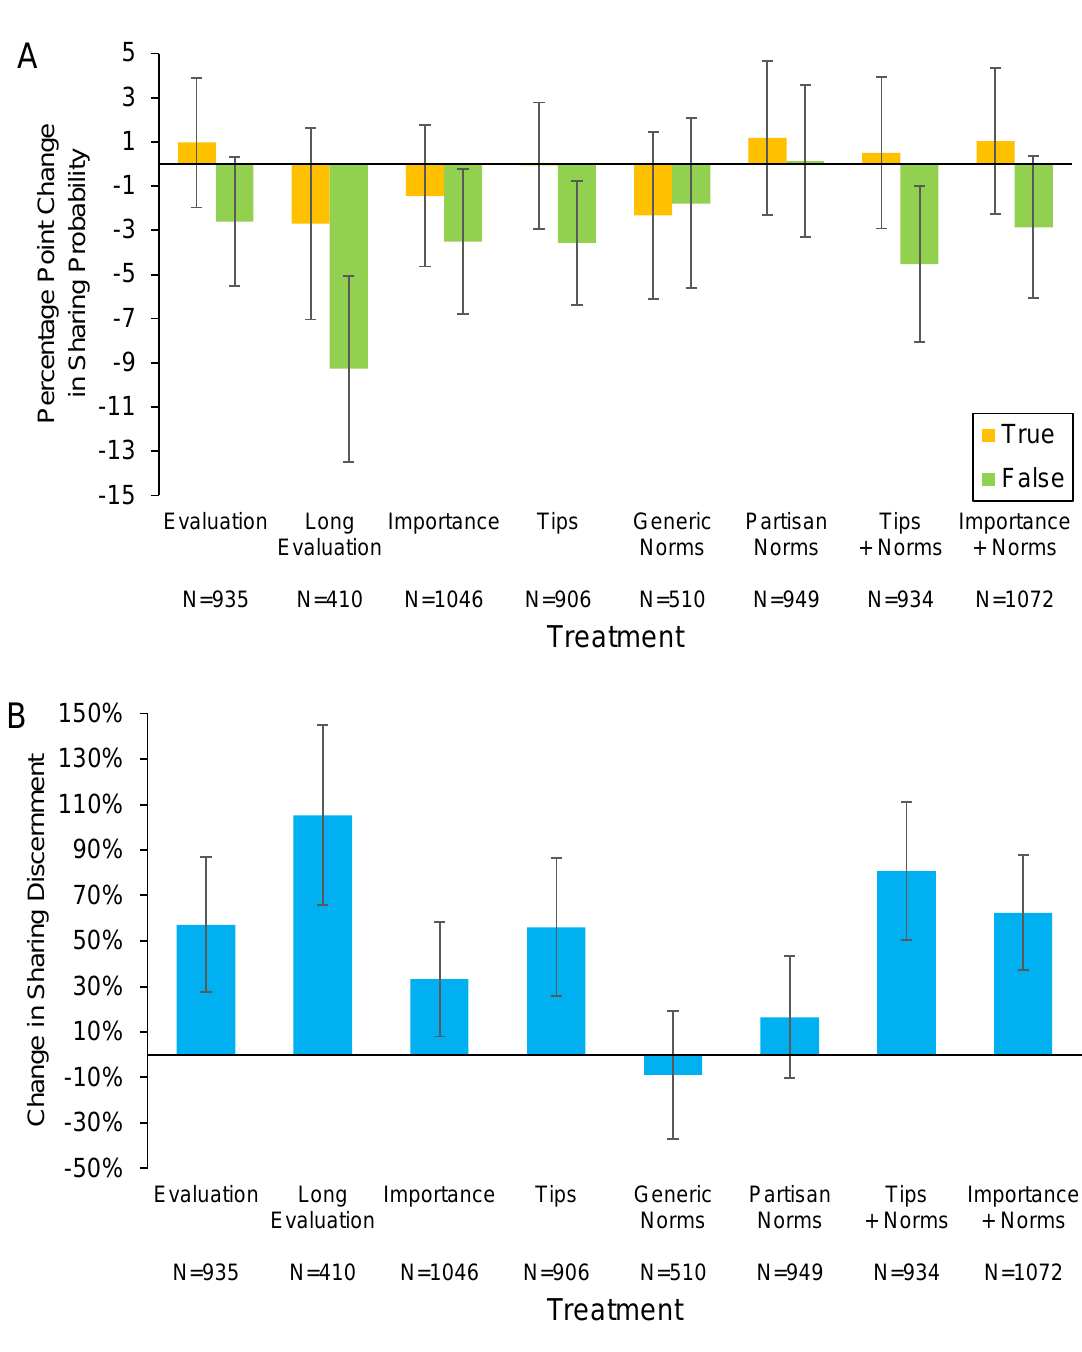
Figure 3. Effect of accuracy prompt interventions. (A) Percentage point change in sharing probability of true and false headlines caused by each treatment relative to the control. (B) Percent change in discernment (sharing probability of true headlines minus sharing probability of false headlines) caused by each treatment relative to the control. Sample size for each treatment shown (control condition included 2,100 participants). Error bars indicate 95% confidence